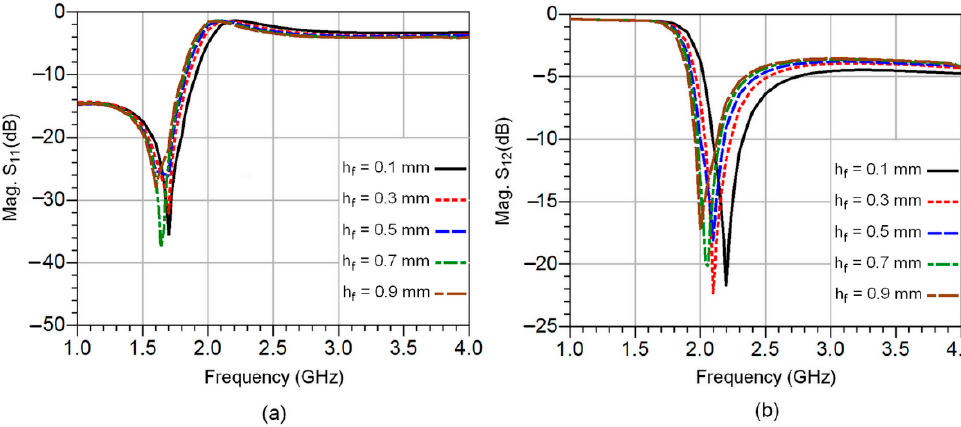
Figure 3. The simulated S-parameters of the CSRR sensor circuit at various fat layer thicknesses: the reflection coefficients in ( a ) and transmission coefficients in ( b ).